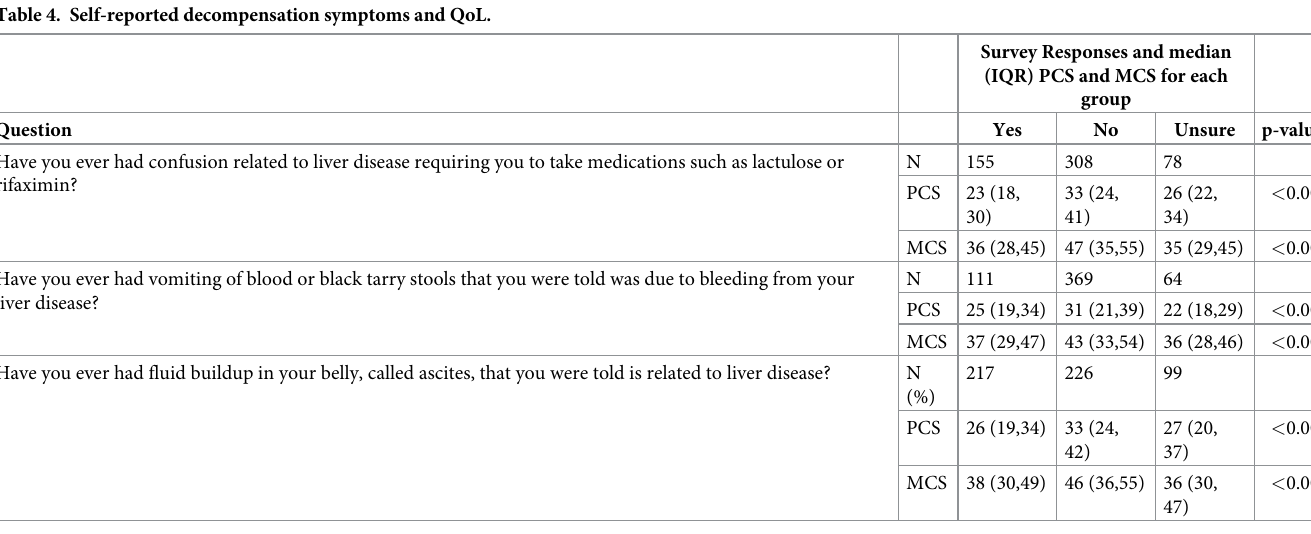
Table 4. Self-reported decompensation symptoms and QoL.